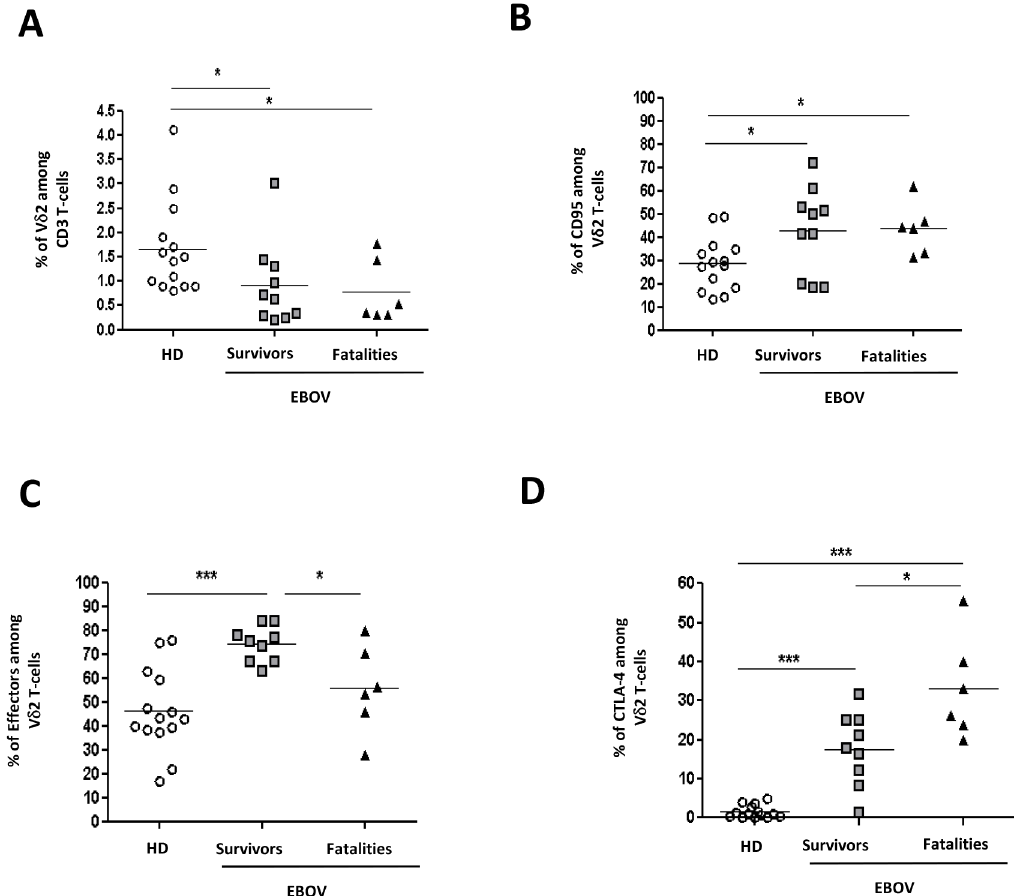
Fig 1. Frequency of V δ 2 T-cells in survivorsand in fatalities. The frequency of V δ 2 ( A ), V δ 2 pos CD95 pos ( B ), of V δ 2 pos CCR7 neg ( C ) and V δ 2 pos CTLA-4 pos ( D ) was analyzedin HD (n = 14), EBOV-survivors (n = 10) and EBOV- fatalities (n = 6). Statistical analysiswas performed by using Mann Whitney test and differences were considered significantwith a p < 0.05 and highlightedwith an asterisk. * : p < 0.05; ** : p < 0.01; *** : p <